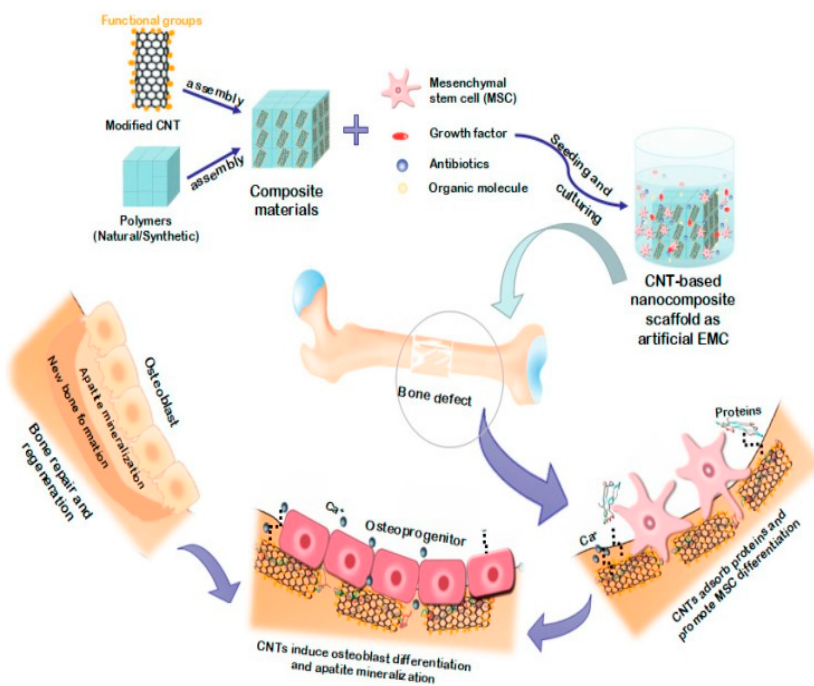
Figure 23. Schematic illustration showing the role of carbon nanotubes for the scaffolding in bone tissue engineering and regeneration. Reproduced from [191] with permission of MDPI under the terms and conditions of the Creative Commons Attribution license.